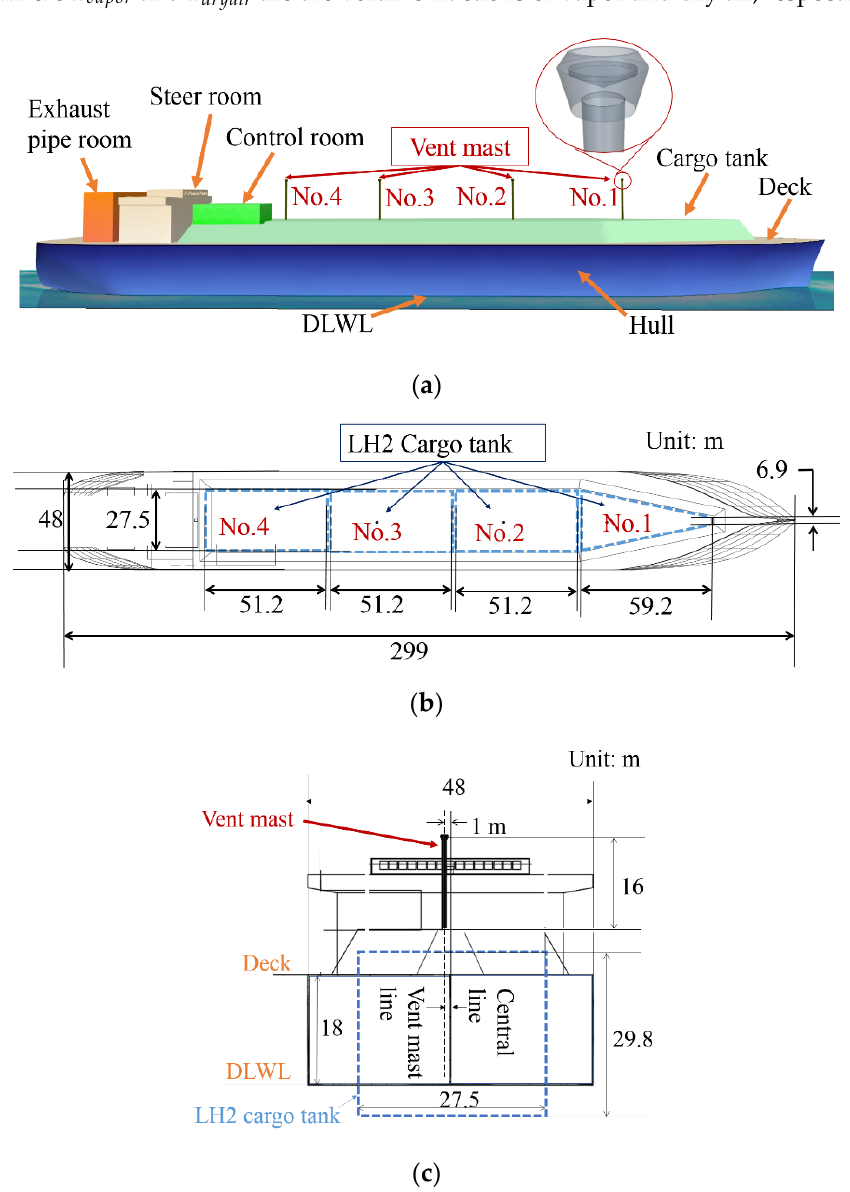
Figure 1. Design of the liquefied hydrogen (LH2) carrier equipped with four vent masts and four cargo tanks: ( a ) Three dimensional (3D) model ( b ) top view; and ( c ) front view.